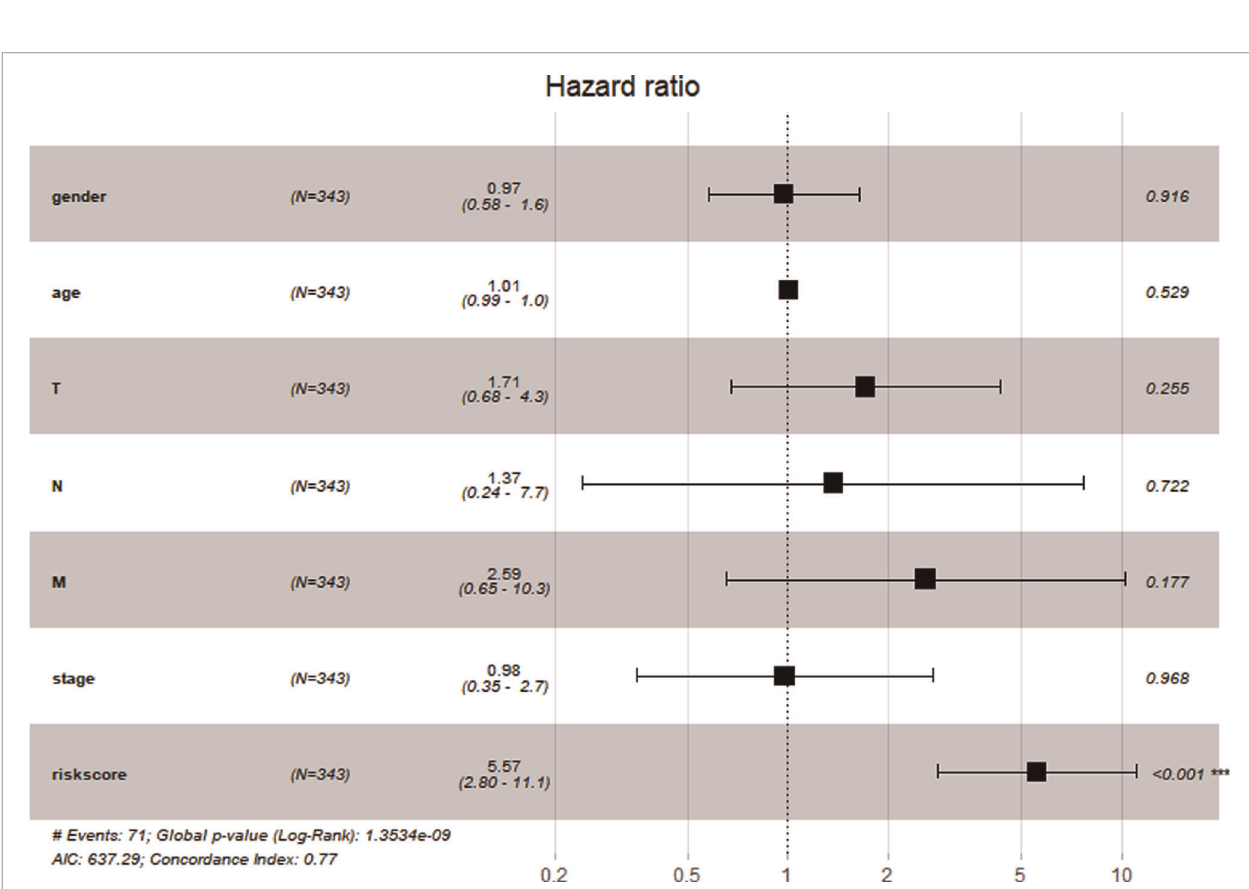
FIGURE 6 | Prognostic value of the Risk Score Signature. Forest plot showing that the Risk Score Signature was an independent prognostic